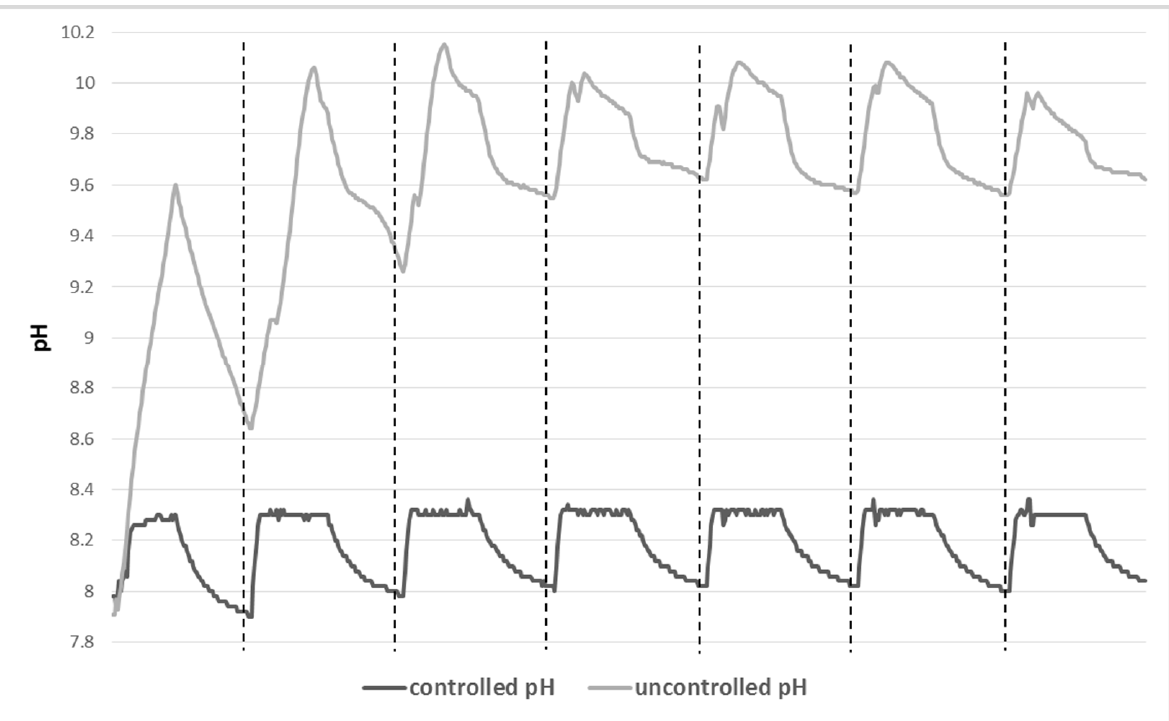
Figure 2. Average evolution of pH during the seven days of the three experimental weeks in both conditions.